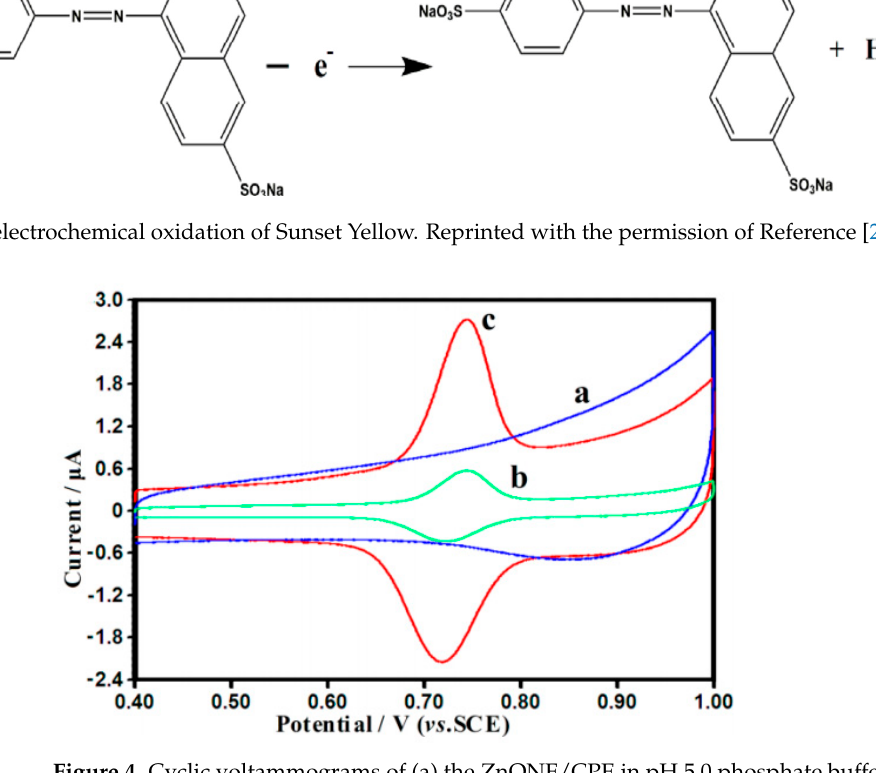
Figure 5. Ball and stick atomic model of Tartrazine. S. M. Ghoreishi et al. [25] also detected TR in presence of Red 10B at Nano-Au mod- ified CPE in 2013. The CV studies indicated that both the dyes show irreversible cyclic voltammetric behavior as displayed in Figure 6. This type of modified electrode gave a good sensitivity for detection of TR in the presence of Red 10B. Therefore, the modified electrode showed great conductivity and sensitivity with a detection limit of 0.017 µM. In 2016, K. Nezhad et al. [26] detected TR electrochemically at poly (p-amino benzene sul- fonic acid)/poly (BSA) and ZnO NP modified CPE. The CV showed an irreversible oxida- tion peak with enhanced peak current due to increased conductivity and faster electron transfer rate; inorganic and organic molecules/ions do not affect the detection of TR at the modified electrode. The electrode gave a detection limit of 80 nM and with real sample analysis using processed foodstuffs gave a recovery rate of 98% indicating good accuracy